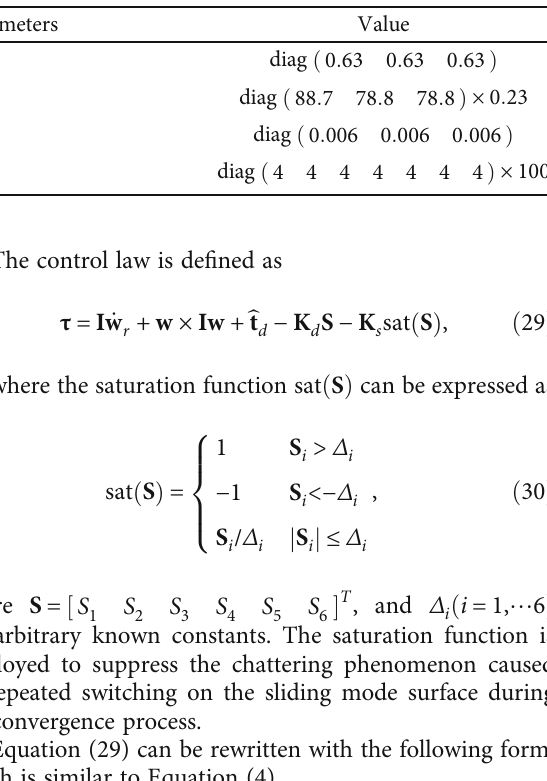
Table 5: RBF neural network control